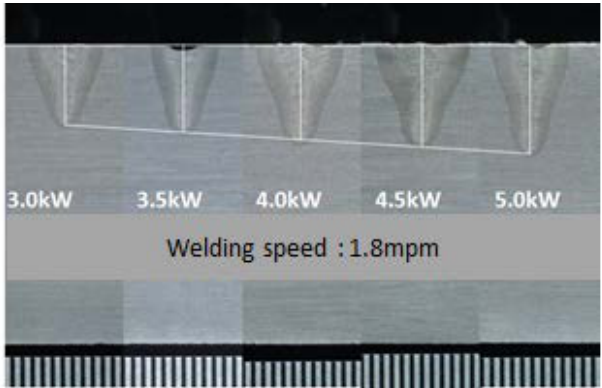
Figure 12. Variation of penetration depth, according to laser-power change by macro cross-sectional shape analysis.